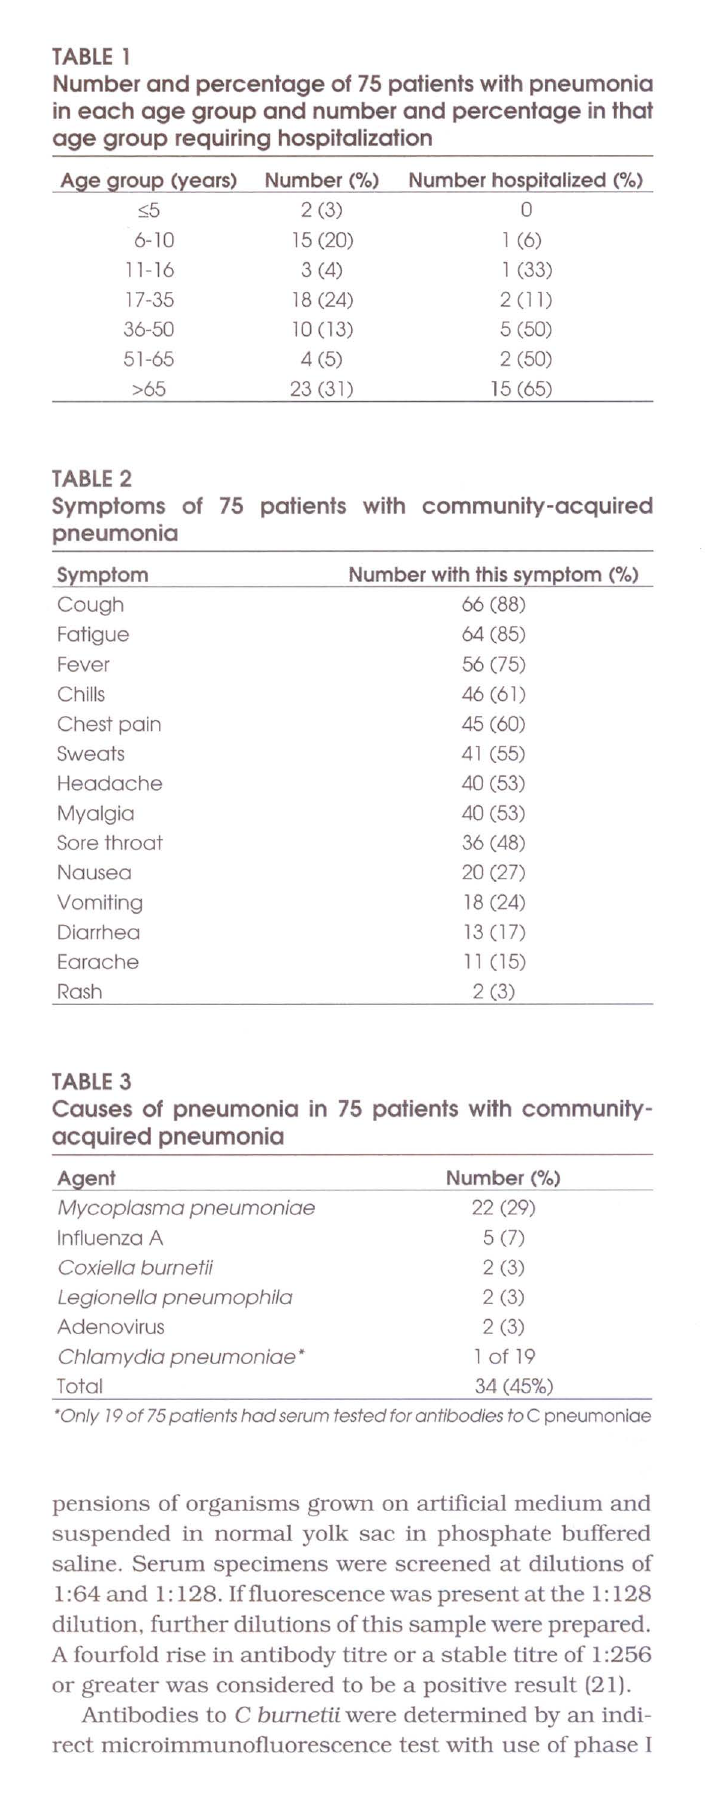
Number and percentage of 75 patients with pneumonia in each age group and number and percentage in that age group requiring hospitalization